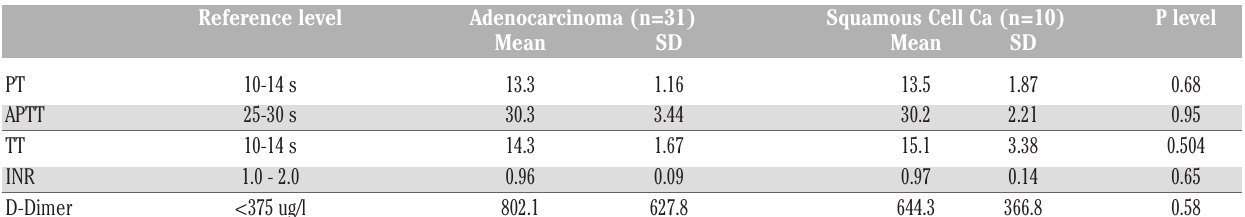
Table 2. Baseline mean and SD of hemostatic parameters and tumor markers of different type of